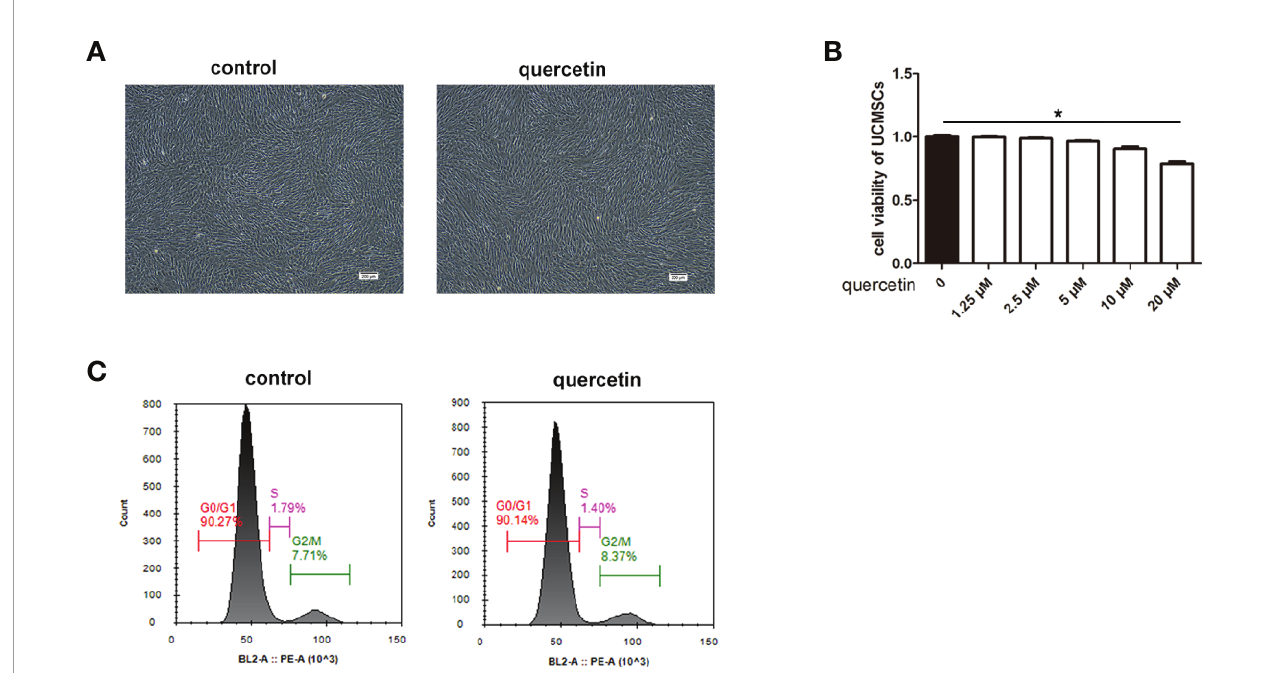
FIGURE 2 | Morphology, viability, phenotype, and cell cycle of UCMSCs. Untreated UCMSCs and UCMSCs that were pretreated with 10 m M quercetin were cultured for 3 days. (A) Morphology (100×). Untreated UCMSCs and UCMSCs that were pretreated with 10 m M quercetin shared the same morphology. (B) UCMSC viability was examined by MTT assay. Quercetin at 20 m M in fl uenced UCMSC viability. *P < 0.05, mean ± SEM, n=5. (C) The proportion of cells in the G1, S, and G2/M phases of the cell cycle in untreated UCMSCs and UCMSCs that were pretreated with 10 m M quercetin. No signi fi cant differences were detected. Representative examples are